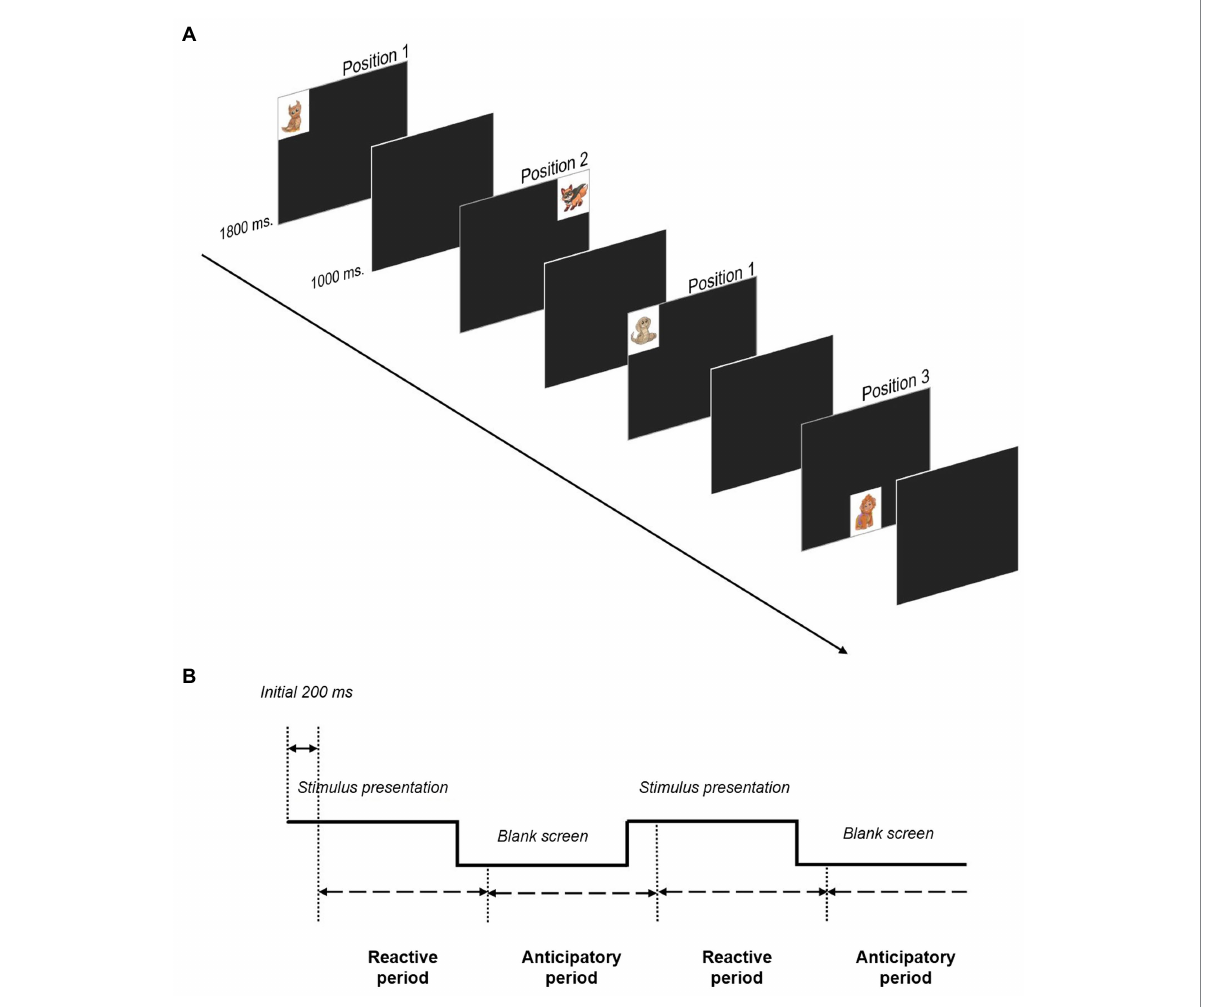
FIGURE 1 Task procedure of a complete sequence (1-2-1-3) following Clohessy et al. (2001). (A) Stimulus are presented in the figure in large size, although a transition through different sizes was employed to create a looming effect. Stimulus presentation (1800 ms) and anticipatory period (1000 ms) durations were fixed in the sequence. Complex (from Position 1-to Position 2 and Position 1-to Position 3) and easy transitions (Position 2-to Position 1, Position 3-to Position 1) can be found in the figure. (B) Visualization of the definition of reactive (stimulus presentation) and anticipatory periods (blank screen). Cartoons by GraphicMama-team from